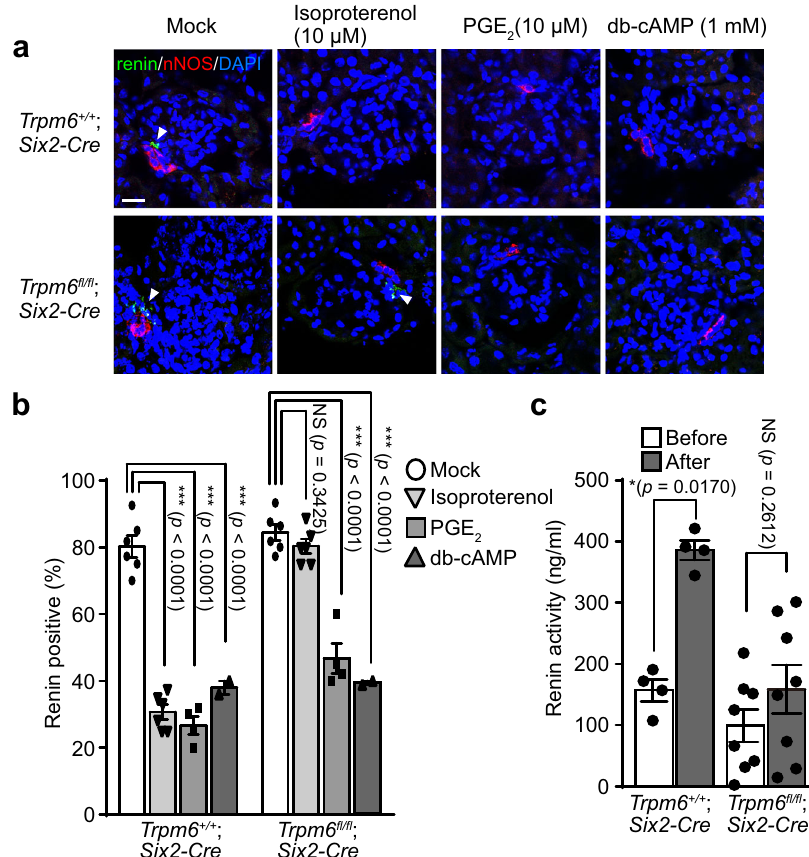
Fig. 4 Impaired renin secretion upon adrenergic stimulation. a Slices of kidneys dissected from 2- to 3-month-old mice of the indicated genotypes were incubated with the indicated chemicals for 30 min and cryosections of these kidney slices were subjected to immuno fl uorescence staining with an anti- renin antibody (green), an anti-nNOS antibody (red), and DAPI (blue). Arrowheads indicate renin-positive cells. Bar, 20 μ m. A representative result from three independent experiments with similar results are shown. b The percentages of glomeruli with adjacent renin-positive cells are shown as means ± SEM (in both genotype, n = 6 (mock), 6 (Isoproterenol), 4 (PGE 2 ), and 2 (db-cAMP)). The p -values were determined by two-way ANOVA with Holm-Sidak post hoc tests. *** p < 0.001. c 2- to 3-month-old mice of the indicated genotypes were intraperitoneally administered with 10 mg/kg isoproterenol, and plasma collected the day before and 30 min after drug administration were subjected to renin activity measurement ( n = 4 for Trpm6 + / + ; Six2-Cre , and n = 8 for Trpm6 fl / fl ; Six2-Cre ). Data are shown as means ± SEM. The p -values were determined by two-way ANOVA with Holm-Sidak post hoc tests. * p <